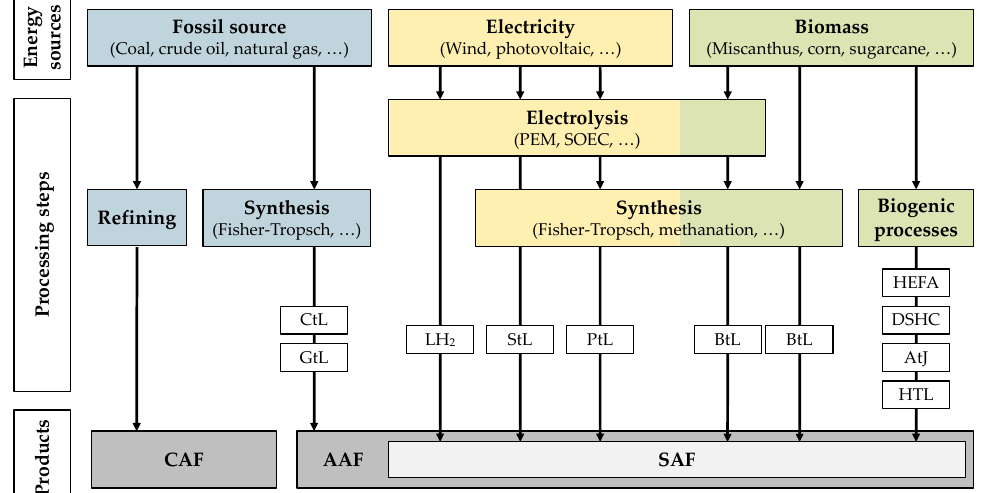
Figure 1. Classification and production pathways of aviation fuels (adapted from [32]).